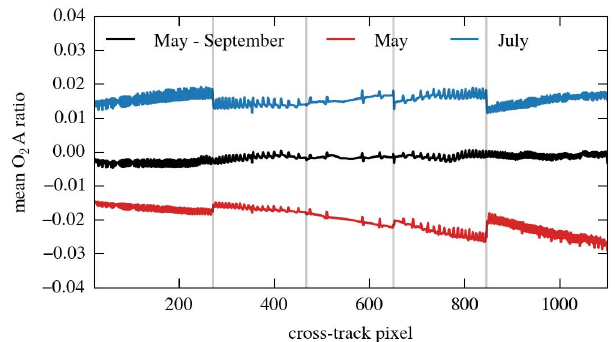
Figure 2. Along-track mean of the corrected oxygen A ratio. For each time period, the mean is calculated from 100 randomly se- lected swaths. The vertical lines mark the transition between the five detectors of